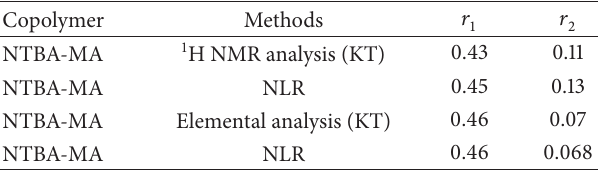
Table 4: The values copolymerization ( 𝑟 1 and 𝑟 2 ) for NTBA ( 𝑀 1 )- MA ( 𝑀 2 ) monomer pair determining by KT and NLR methods using 1 H NMR and elemental analysis